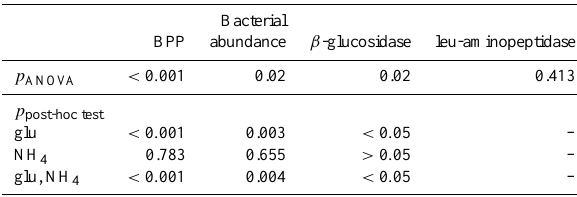
Table 1. Statistical analysis of the enrichment assays. Significance levels of ANOVA ( p ANOVA ) and post-hoc comparisons versus the control ( p post-hoc test ) are given. One-way ANOVA with post- hoc comparison by the Holm-Sidak method was carried out for bacterial protein production (BPP), bacterial abundance and leu- aminopeptidase. Data for β -glucosidase activity were not normally distributed and, therefore, ANOVA on ranks combined with post- hoc comparison by Dunnett’s Method was